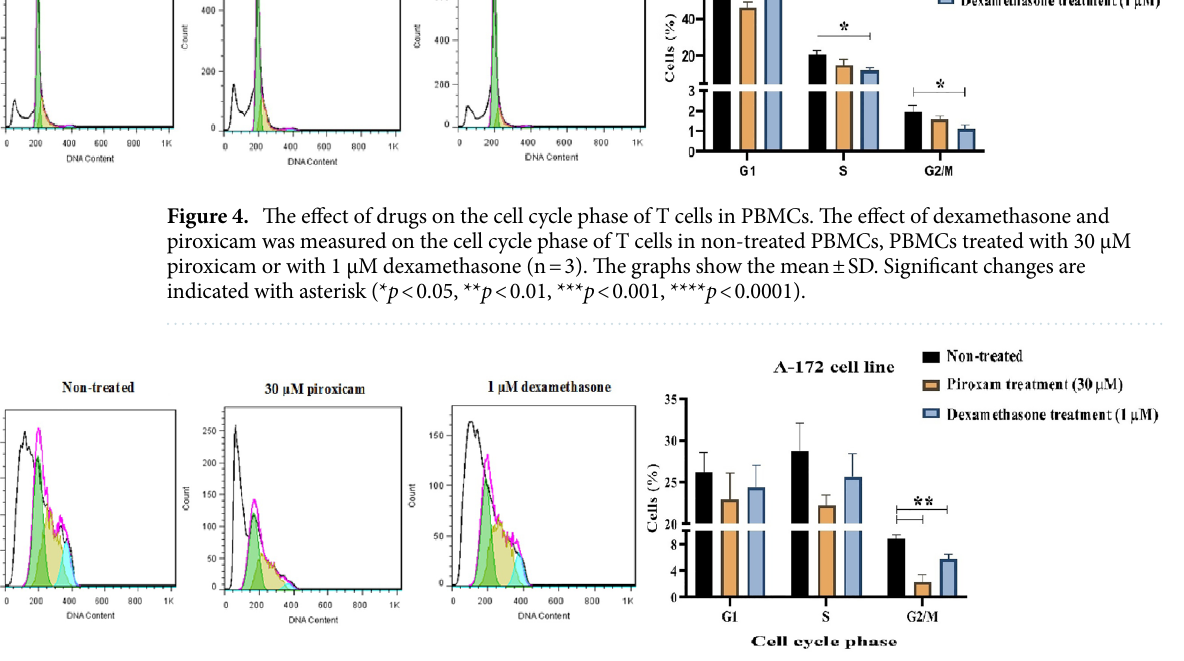
Figure 5. The effect of drugs on the cell cycle phase of A-172 cell line. The effect of dexamethasone and piroxicam was measured on the cell cycle phase of A-172 cells in non-treated, and treated with 30 μM piroxicam or with 1 μM dexamethasone (n = 3). The graphs show the mean ± SD. Significant changes are indicated with asterisk (* p < 0.05, ** p < 0.01, *** p < 0.001, **** p <